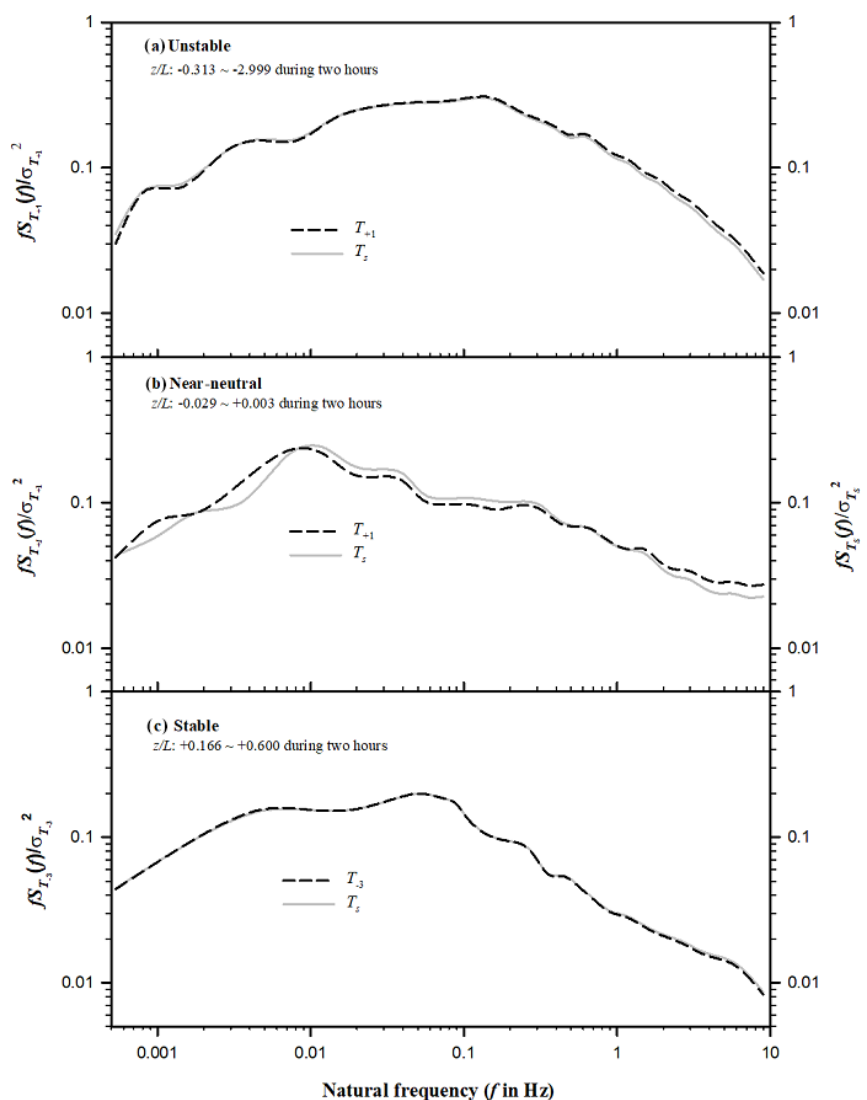
Figure 5. Paired comparisons of power spectra for equation-computed air temperature ( T ) and sonic temperature ( T s ) at each of three atmospheric stratifications: unstable (a) , near-neutral (b) , and stable (c) . T + 1 and T − 3 are equation-computed T from T s and the H 2 O mixing ratio of air sampled by the CPEC system through its sampling orifice in + 1 lag (50ms behind) and in − 3 lags (150ms ahead) of T s measurement; z is the dynamic height of measurement minus the displacement height; L is the Monin–Obukhov length; S T (f ) are the power spectra of T s , T + 1 , and T − 3 at f ; and σ 2 and S T − 3